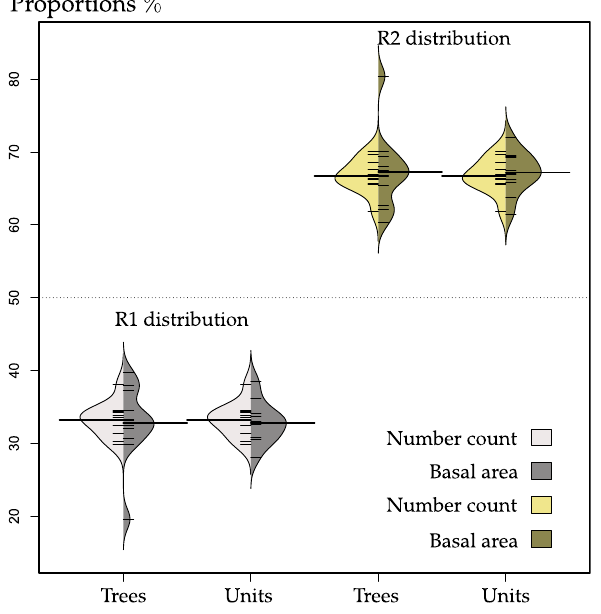
Figure 6. Proportions and distributions of R1 and R2 random trees and units based on the number of individuals or basal area.